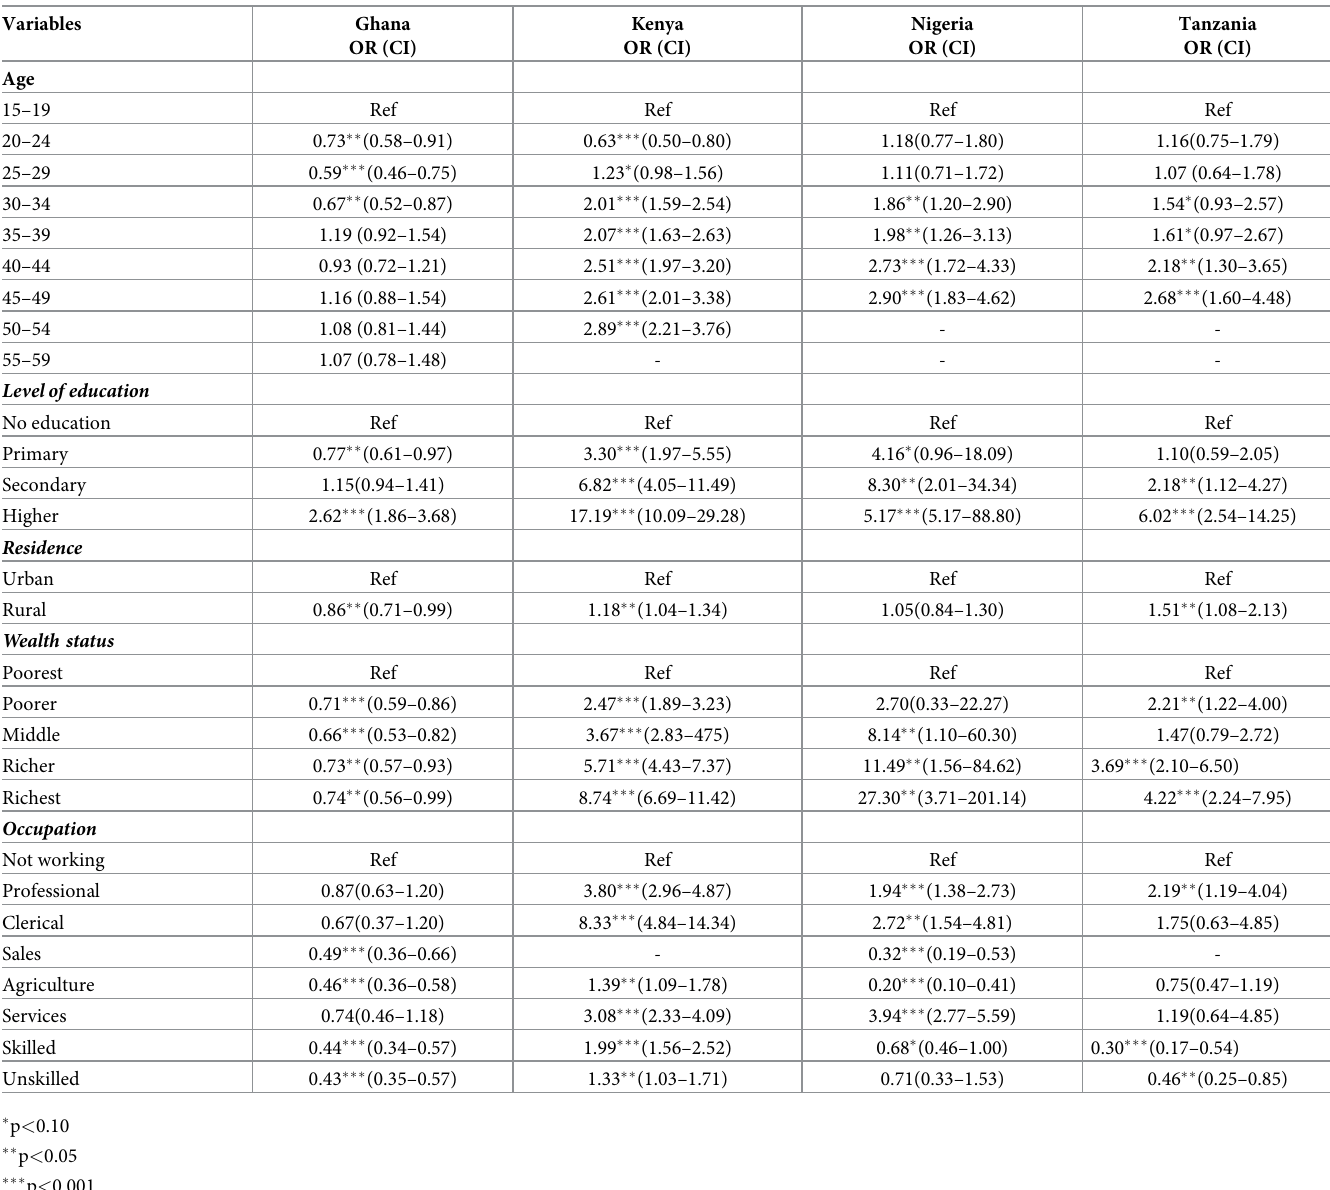
Table 4. Multivariate logistic regression on health insurance coverage